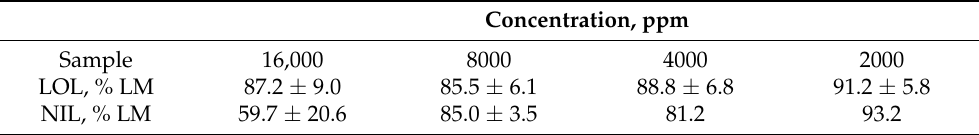
Table 2. In vitro effects of different concentrations of loline on larval migration (LM) of Trichostron- gylus colubriformis .